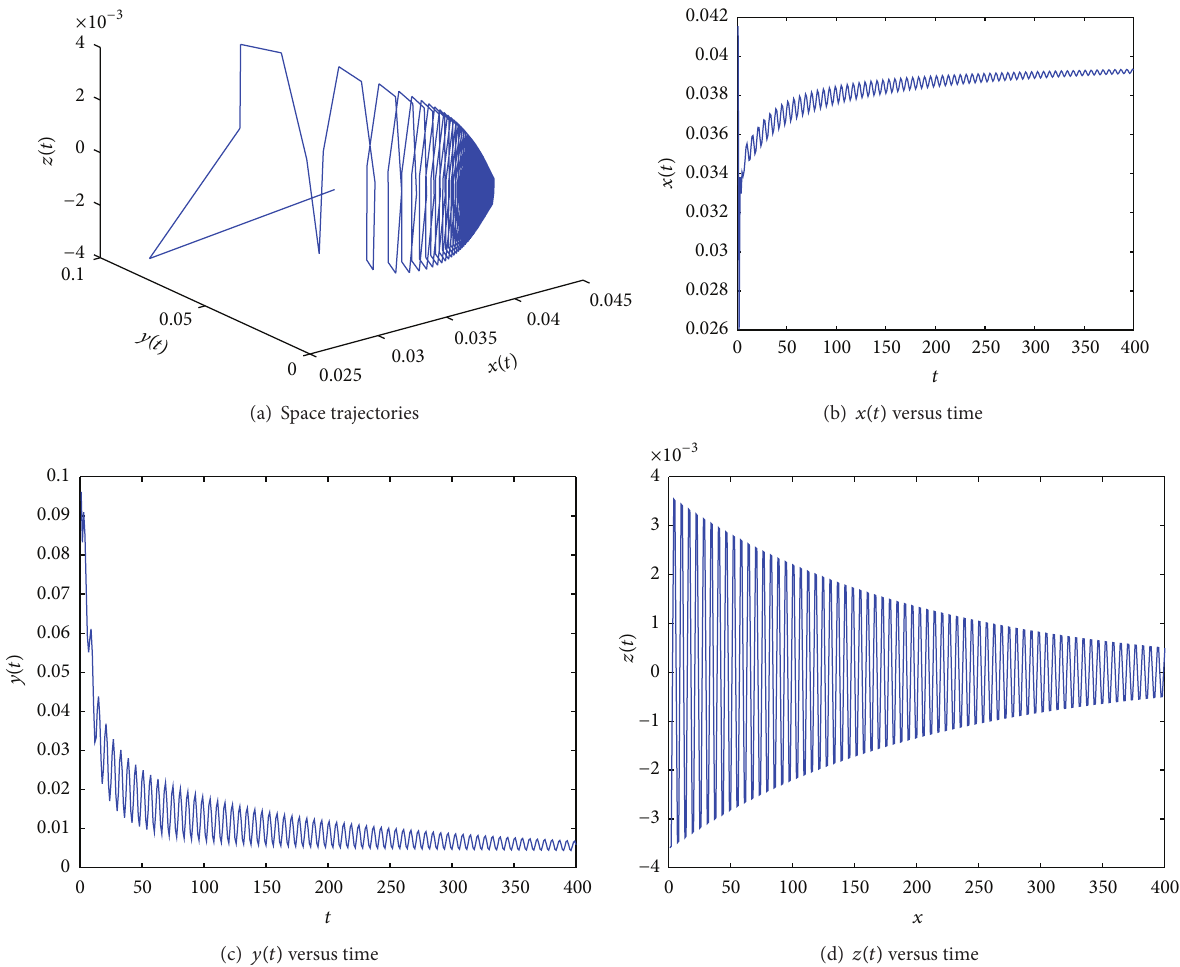
Figure 5: Space trajectory and the time responses of the estimated system about